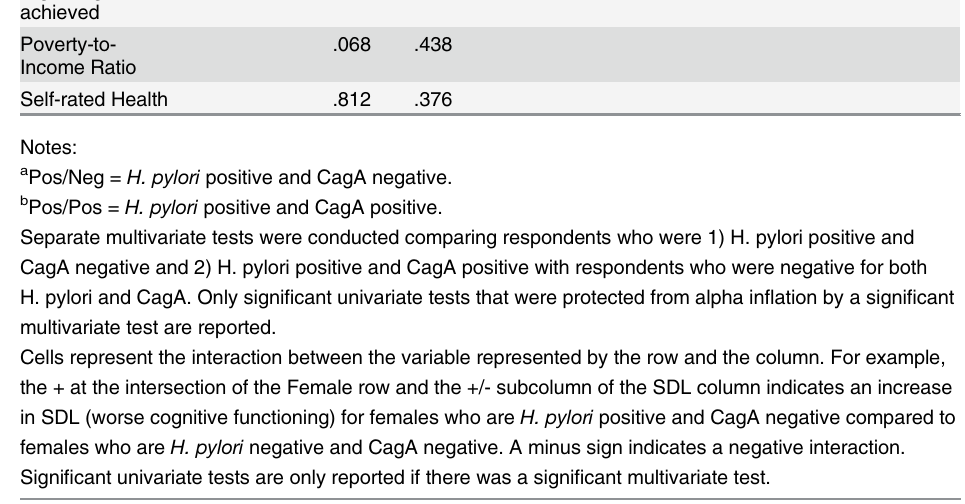
in Fig. 1, Panel B where the SDS scores for whites are similar regardless of H. pylori and CagA status, but non-Hispanic blacks and other race-ethnicity have higher SDS scores if they are H. pylori positive and CagA negative. Finally, there are significant negative interactions in Model 4 between education and both H. pylori and CagA statuses. The form of the interactions is presented in Fig. 2, Panel B. The overall negative trend indicates education is protective of poorer cognitive functioning. However, when respondents were H. pylori positive and CagA positive, education was less protective (i.e., had a flatter slope) but when H. pylori positive and CagA negative, education was slightly more protective (i.e., had a steeper slope). Only two demographic controls, gender and race-ethnicity, had significant univariate inter- actions with significant multivariate with H. pylori and CagA status. Model 1 of Table 5 pres- ents the gender interaction, which is positive for both H. pylori and CagA statuses indicating a stronger effect on females than males. This is shown in Panel A of Fig. 3 where females have higher SDL scores (worse cognitive functioning) if they were H. pylori positive and CagA nega- tive and even higher if they were H. pylori positive and CagA positive, although the latter effect was not statistically significant (Table 5, Model 1). Model 2 presents the race-ethnicity